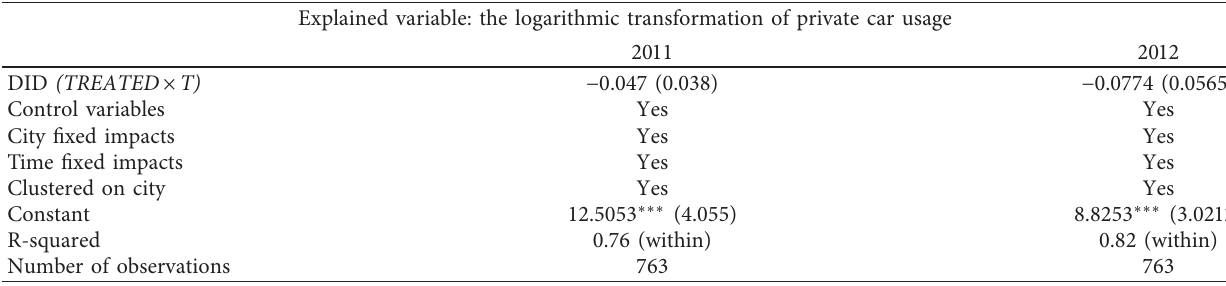
Table 9: Counterfactual test.